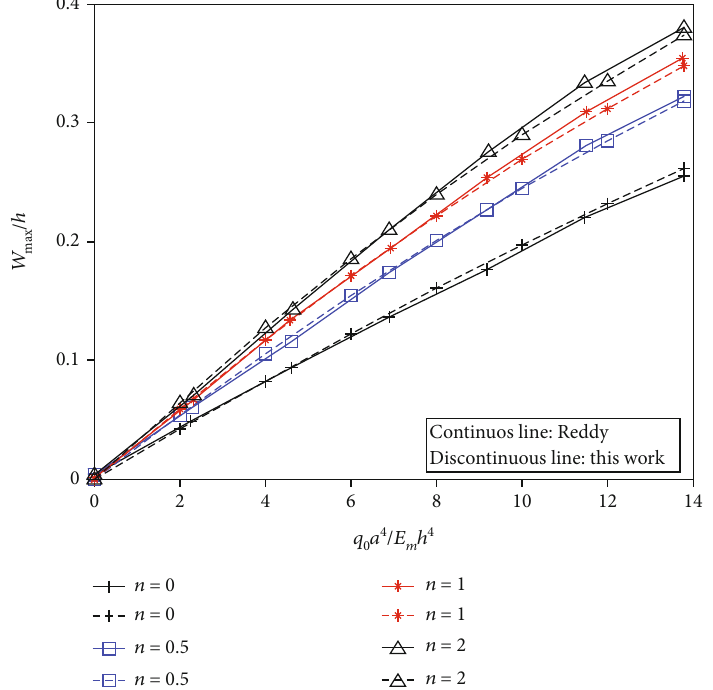
Figure 3: The nonlinear displacements of FGM plate are compared with Reddy ’ s results.